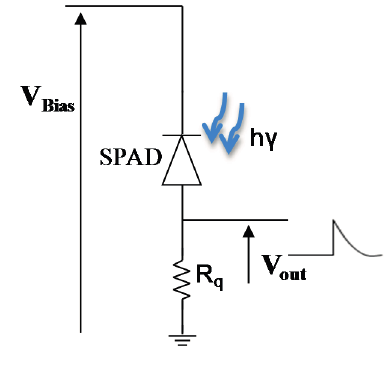
Figure 3. Electrical circuit used for both static and dynamic (dark and light) characterizations, an exterior quenching resistor has been